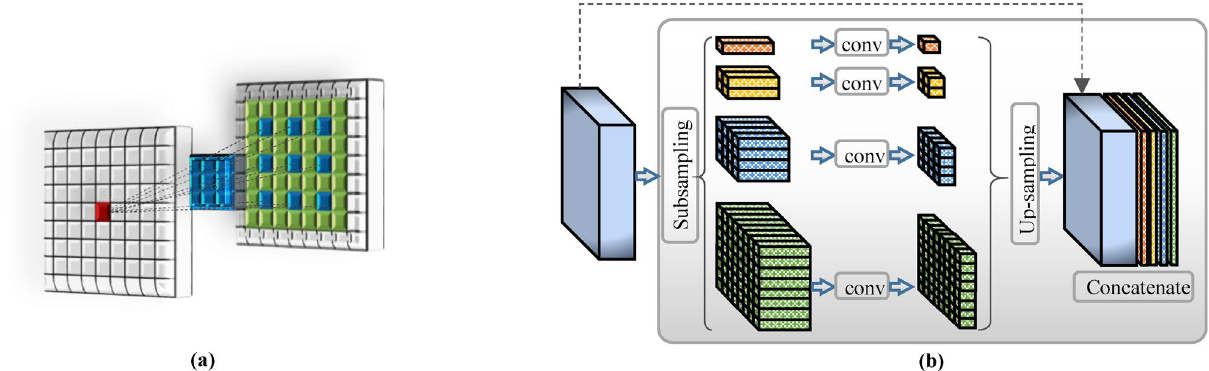
Figure 2. ( a ) An example of dilated convolution at rate of two, which generates a receptive field of 7 × 7 pixels. ( b ) Pyramid Pooling Module (PPM)